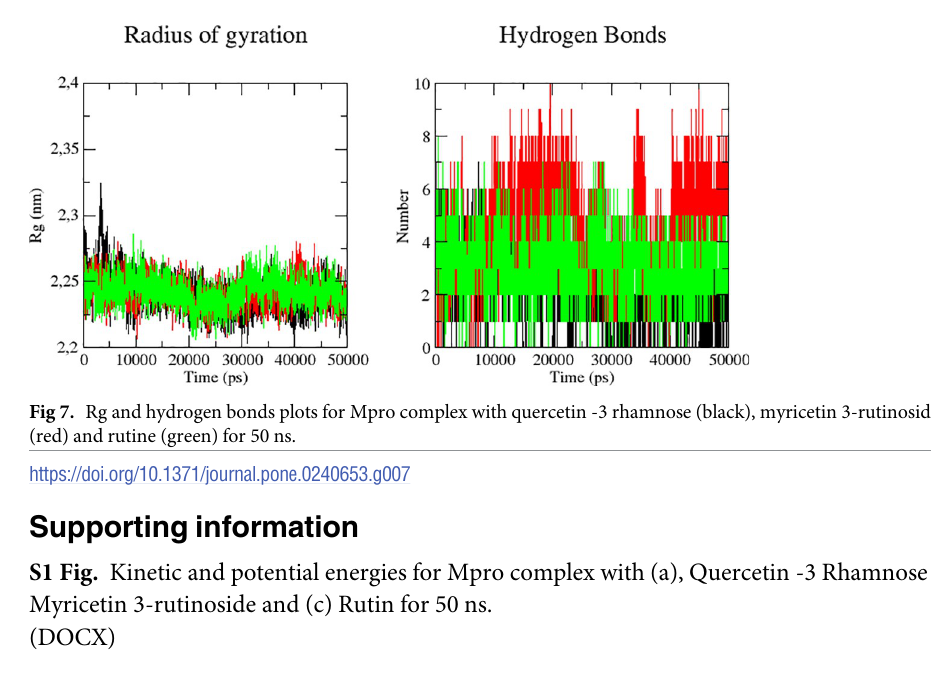
S1 Fig. Kinetic and potential energies for Mpro complex with (a), Quercetin -3 Rhamnose (b) Myricetin 3-rutinoside and (c) Rutin for 50 ns.